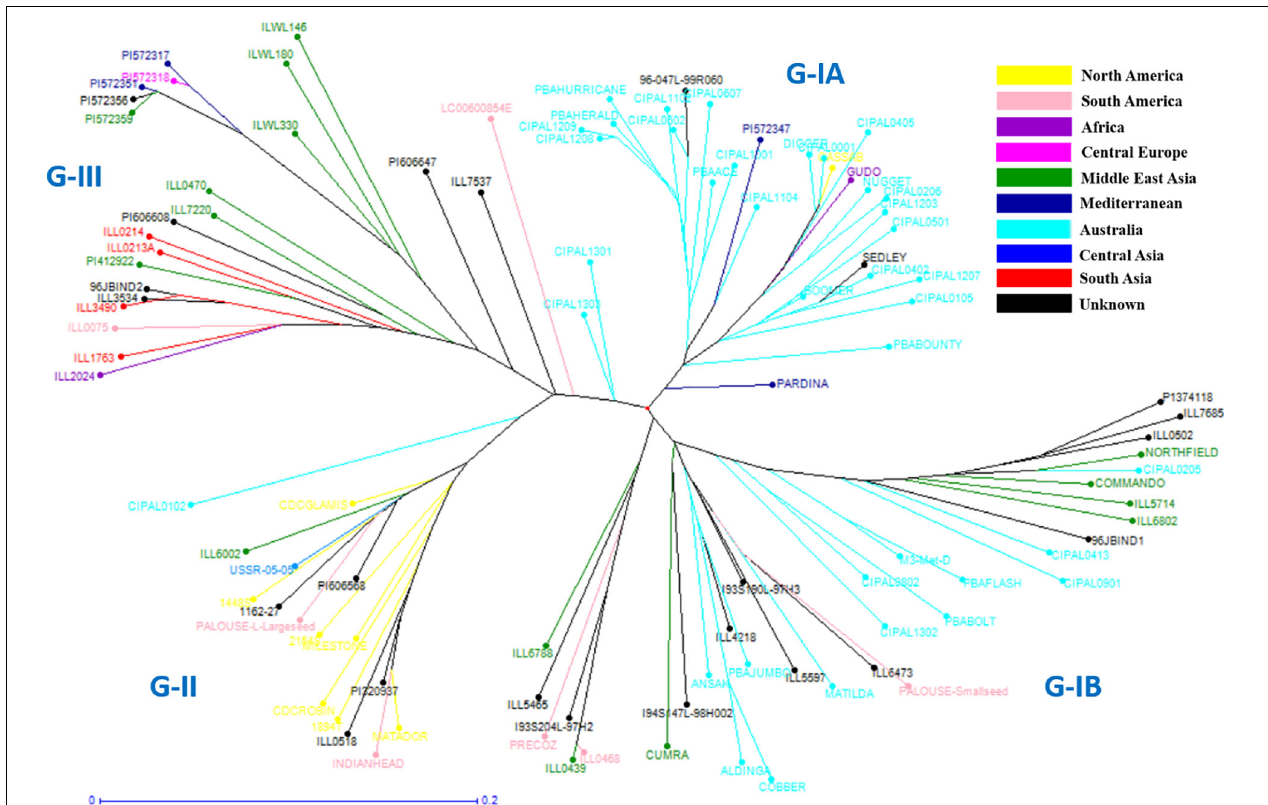
FIGURE 4 | Detailed unweighted neighbor joining dendrogram generated on key L . culinaris